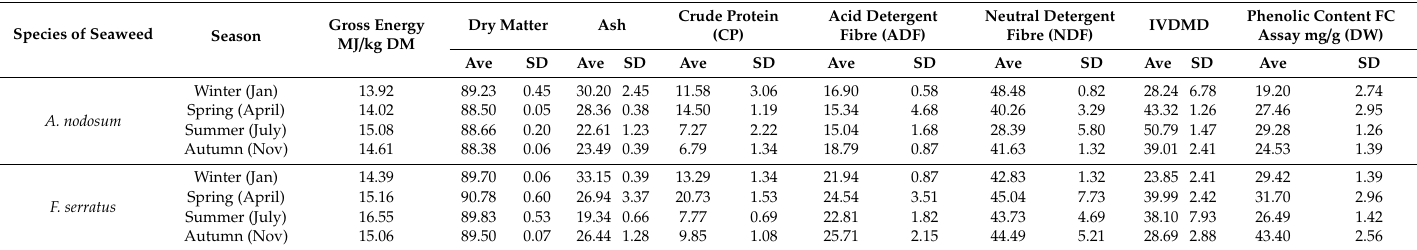
Table 1. Proximate analysis of A. nodosum and F. serratus . All parameters are expressed in terms of % of the overall biomass unless otherwise stated. Species of